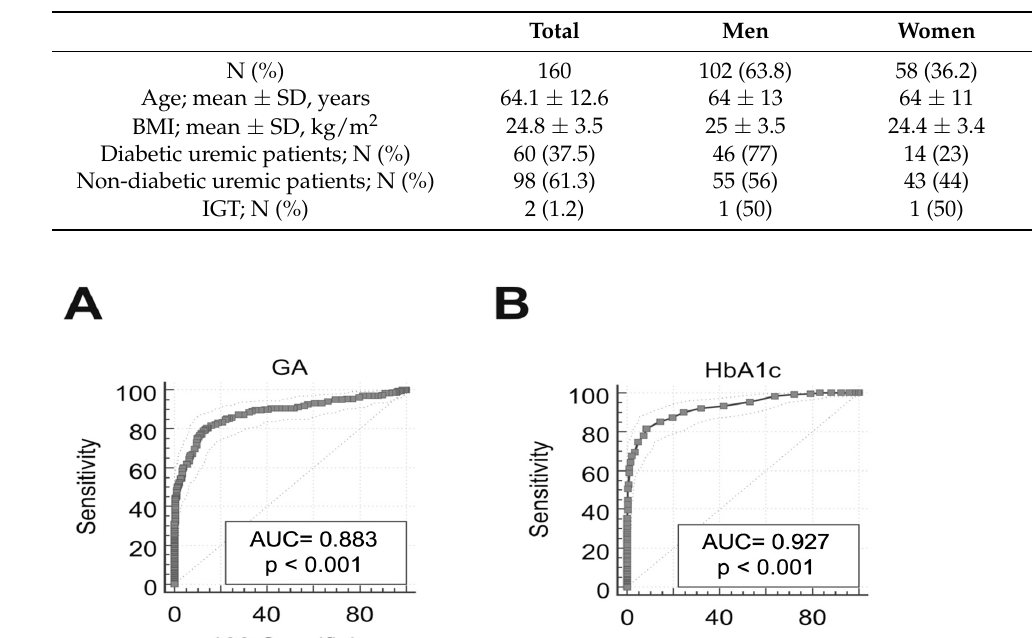
Table 1. Epidemiological data of the 160 hemodialysis patients enrolled in the study. Abbreviations: BMI, body mass index; IGT, impaired glucose tolerance; SD, standard deviation.